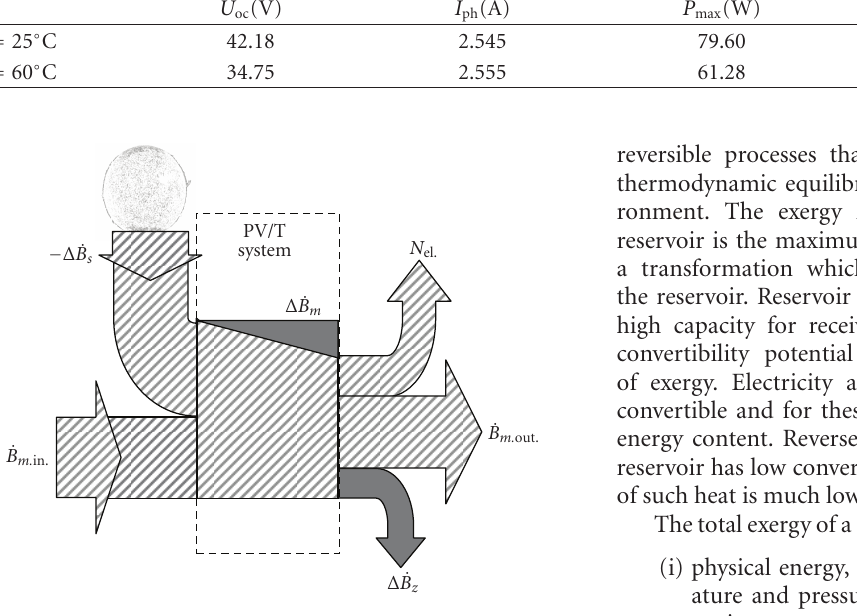
Figure 4: The exergy fluxes flow in PV/T